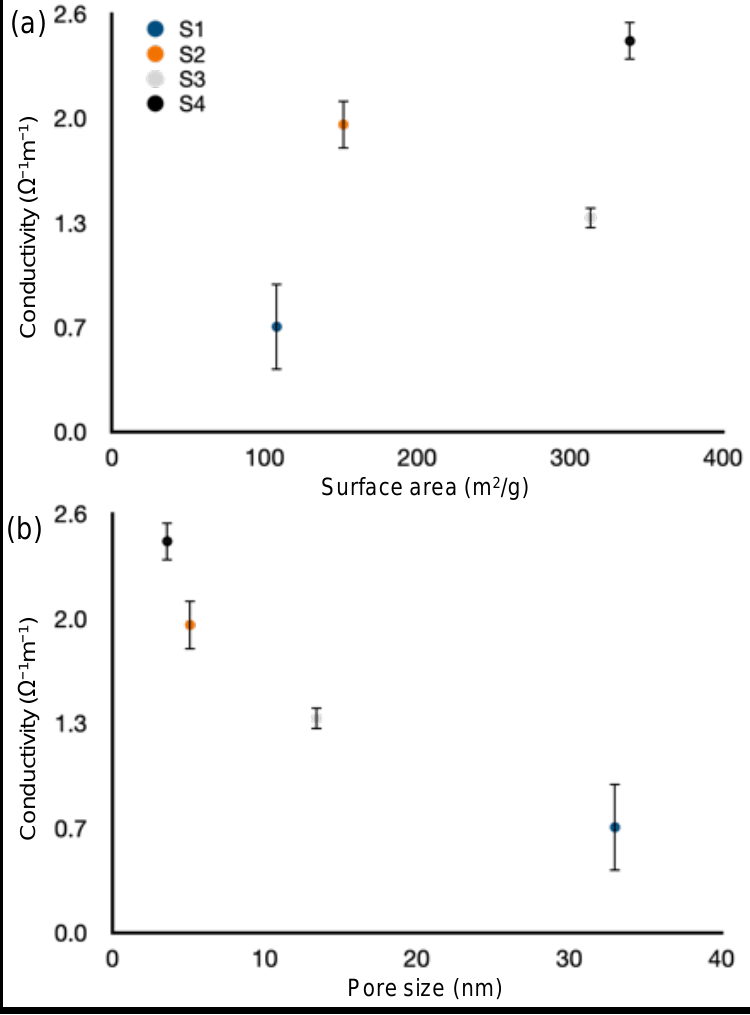
Figure 7. Analysis of the conductivity results: ( a ) surface area effect and ( b ) pore size effect on the electrical conductivity.